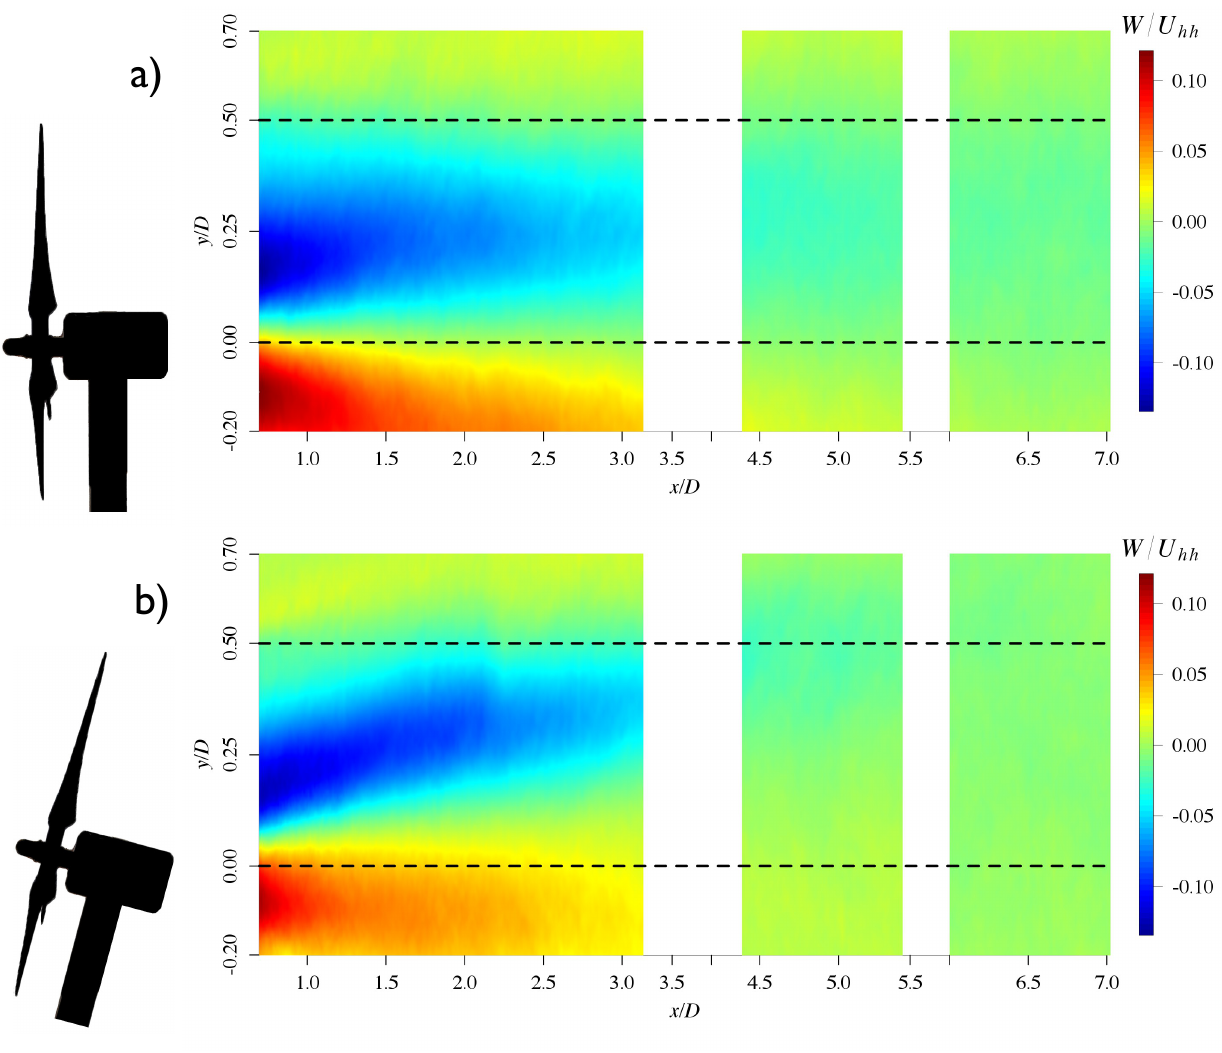
Figure 9. Normalized spanwise velocity component W / U of the wake for the fixed and hh floating cases. In the fixed case, W/U has a symmetric divide of positive and negative hh velocities. In the floating case, the negative shape moves upwards with increasing x/D , while the shape of contours of positive velocity stays at a constant height. Hub height ( y/D = 0) and top blade tip ( y/D = 0.5) are indicated by dashed horizontal